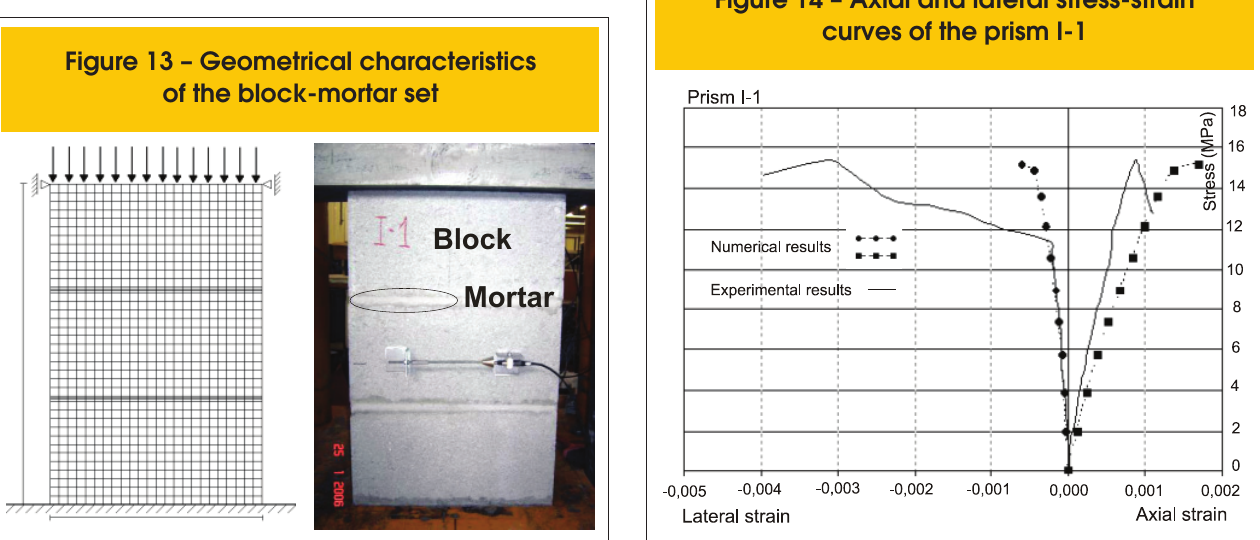
Figure 14 – Axial and lateral stress-strain curves of the prism